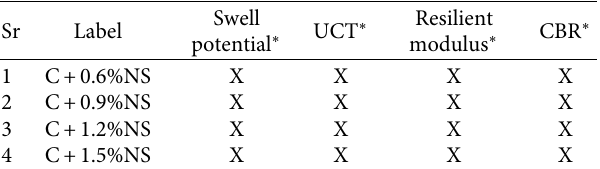
Table 2: Expansive clay and nanosilica composite tests